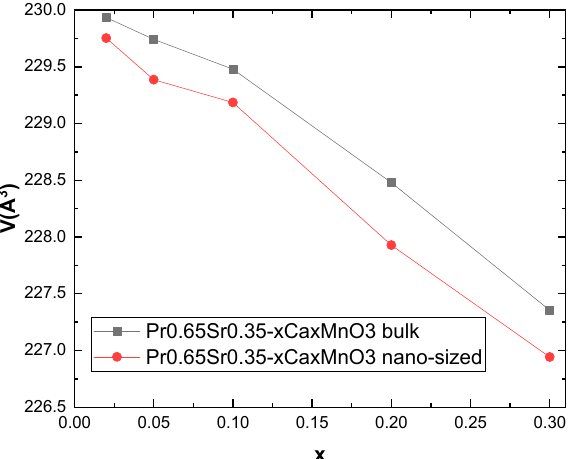
Figure 2. Plot of cell volume change for polycrystalline and nanocrystalline samples. Table 1. Calculated tolerance factors, Mn-O lengths, and crystallite sizes for polycrystalline samples using the Williamson–Hall and Rietveld methods and including particle diameters by optical mi- croscopy.